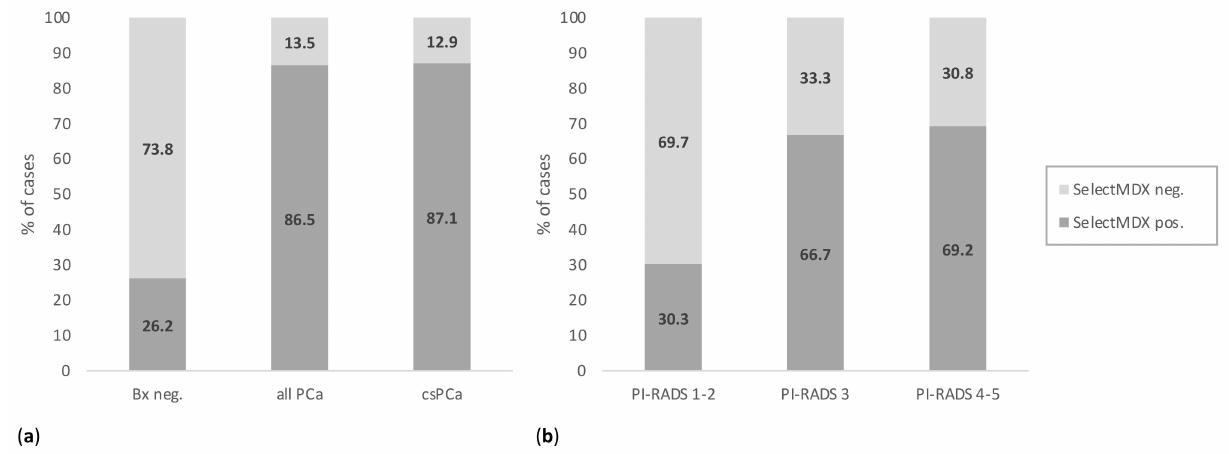
Figure 1. SelectMDx positive and negative results according to ( a ) histologic diagnosis for PCa at biopsy; and ( b ) to PI-RADS score at mpMRI. (PCa = prostate cancer; PI-RADS = Prostate Imaging-Reporting and Data System; mpMRI = multiparametric magnetic resonance imaging; Bx = biopsy; csPCa = clinically significant PCa).